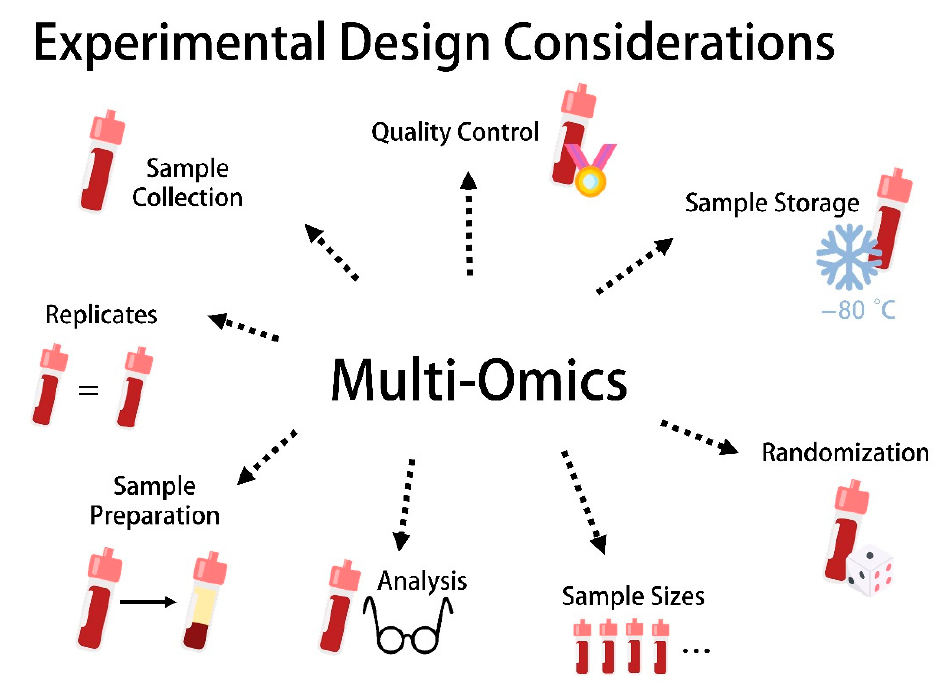
Figure 1. Experimental design considerations for the utilization of multi-omics data.